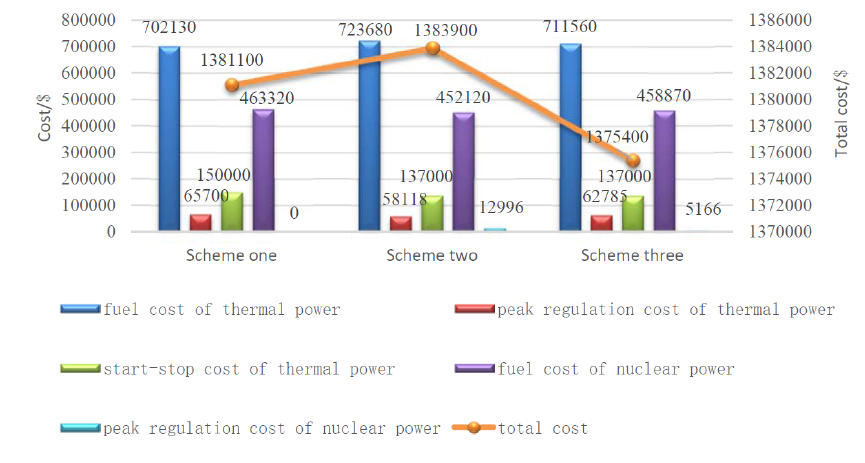
Figure 3. Cost comparison among peak regulation operation